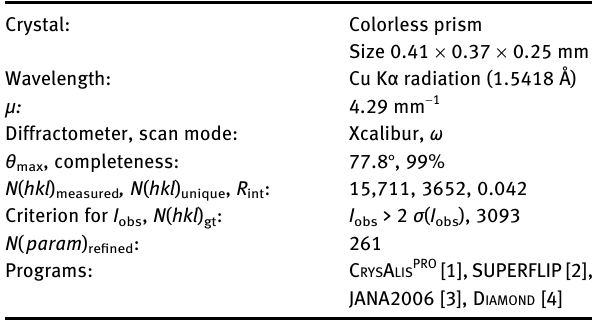
Table  : Data collection and